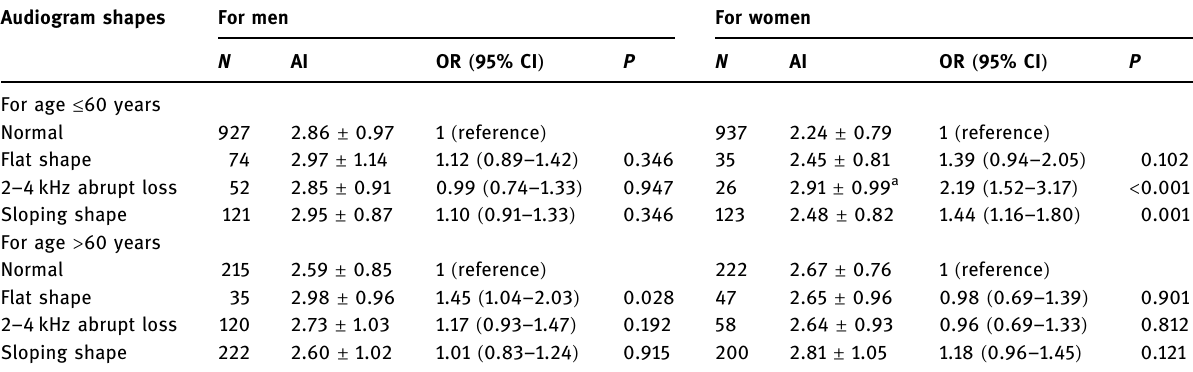
Table 3: Association between AI and the audiogram shapes of hearing loss strati fi ed by sex and age Audiogram